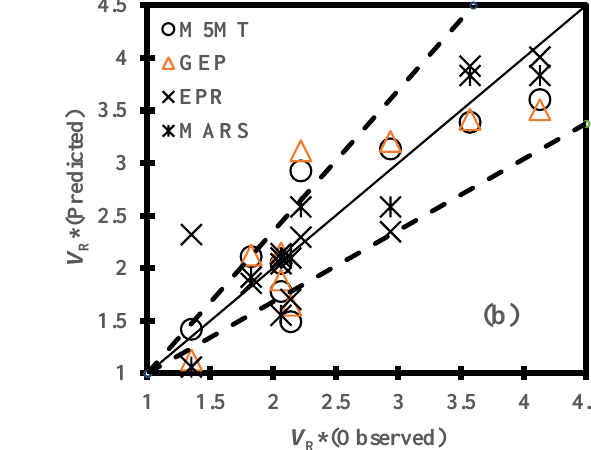
R ∗ for: ( a ) Training and ( b ) testing stage.